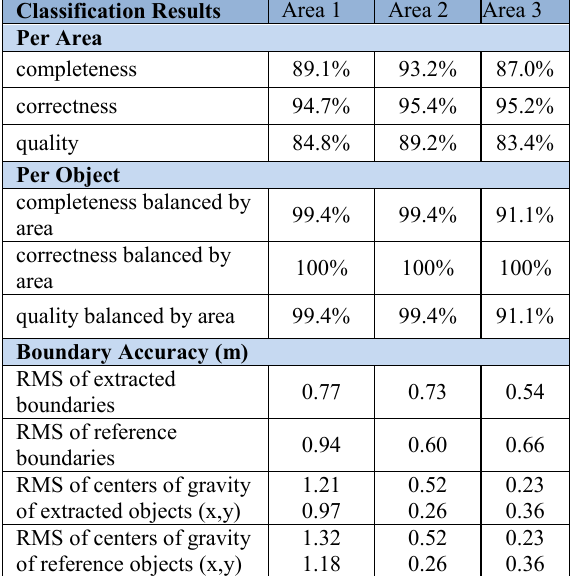
Table 1. Classification results for the buildings class